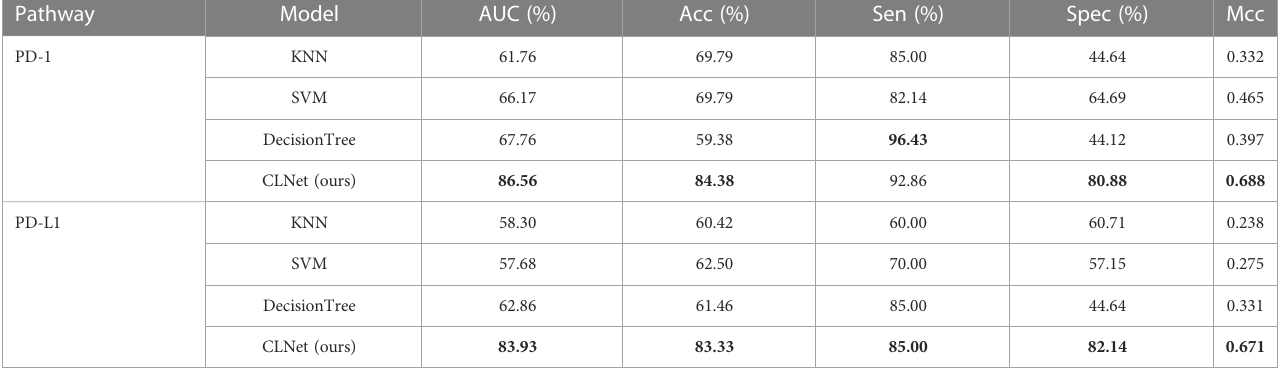
TABLE 3 Performance comparison between our proposed model and traditional machine learning strategies for predicting PD-1 and PD-L1 expressions. Pathway